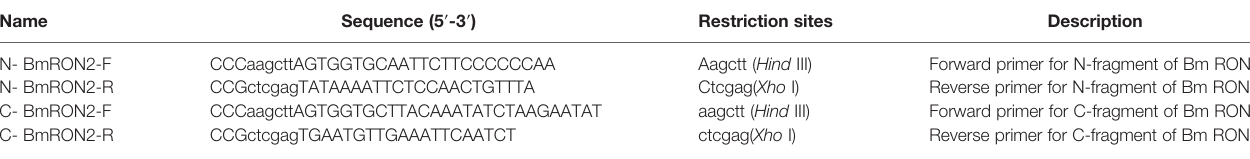
TABLE 1 | Primer sequences used in this